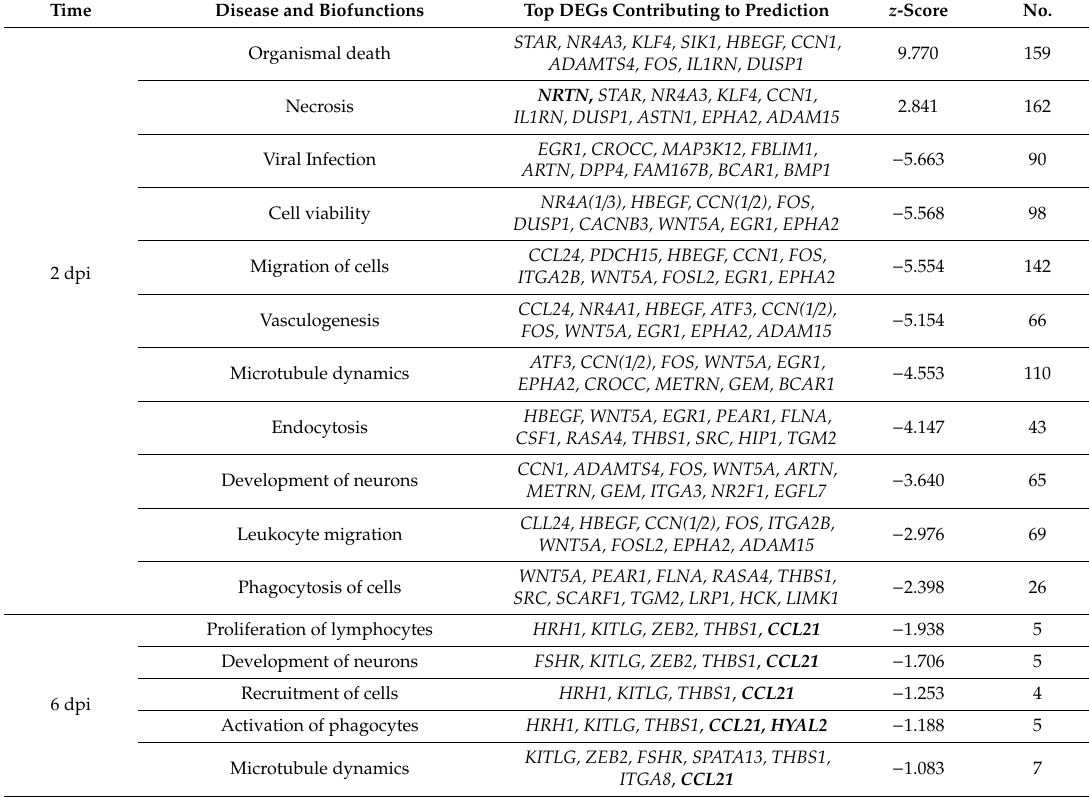
Top disease and functions ( p < 0.01) predicted by IPA for NDV-challenged vs. Non-challenged